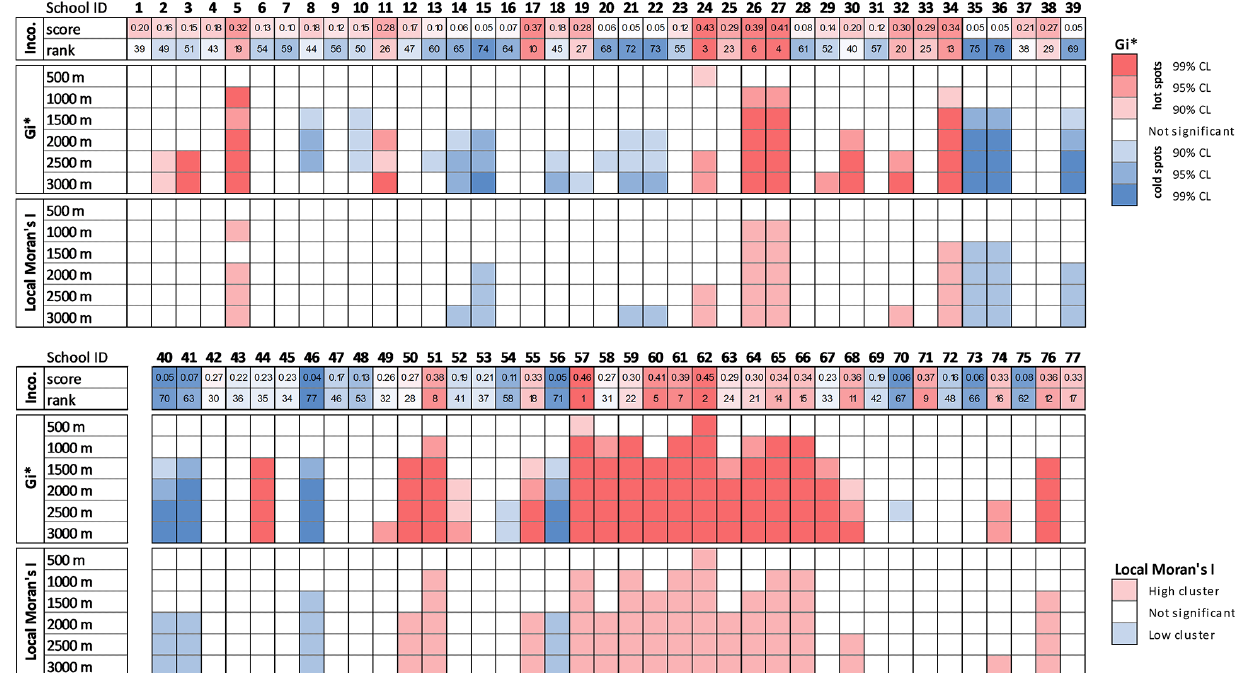
Figure 5. Socio-economic contexts of the 77 secondary schools. 99% CL); and 3) be part of a hot spot of ‘Income’ scores (red cells: light red 90% CL, medium red 95% CL and dark red 99%